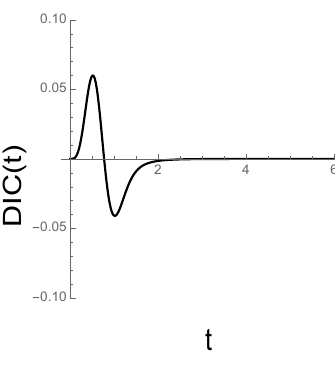
Figure 8. Estimated DIC ( t ) from the example 1-direction serial exhaustive system in Proposition 1A(c) with A L = 3, A H = 8, B L = 4, B H =